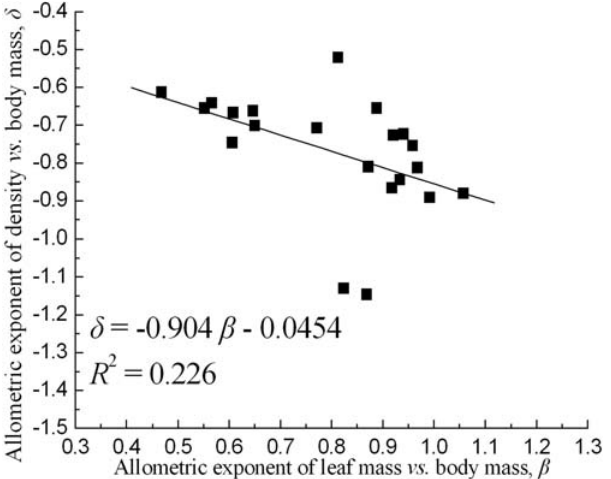
Figure 3. The regression relationships between the two allometric exponents for trees, desert shrubs and monoculture herbaceous plants (spring wheat). The slope is very close to 2 1.